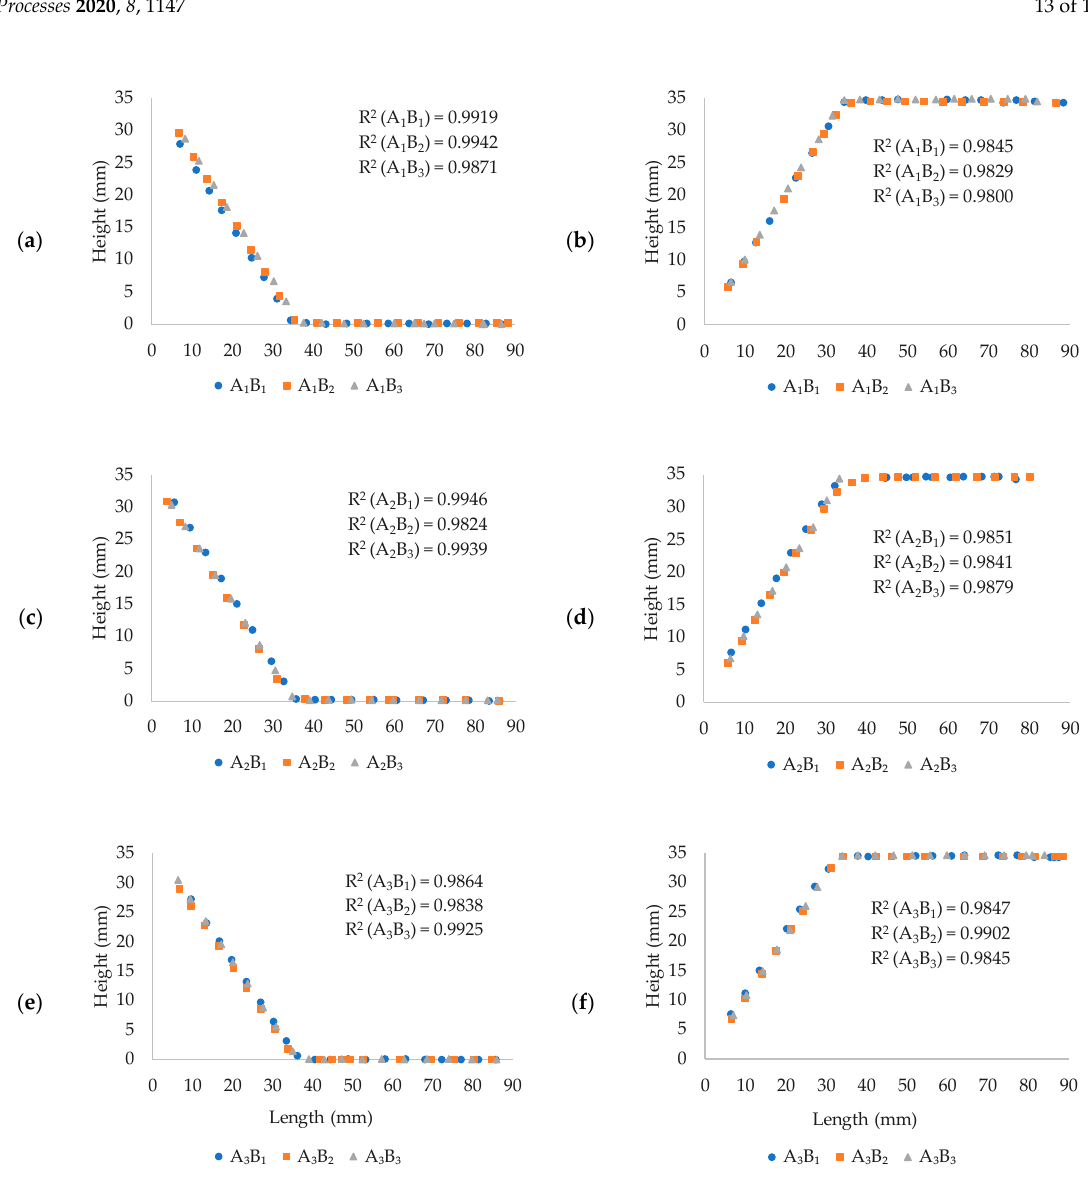
Figure 9. Traces of laminated composites produced using ( a ) SVB for a concave corner, ( b ) SVB for a convex corner, ( c ) MSVB for a concave corner, ( d ) MSVB for a convex corner, ( e ) DVB for a concave corner, and ( f ) DVB for a convex